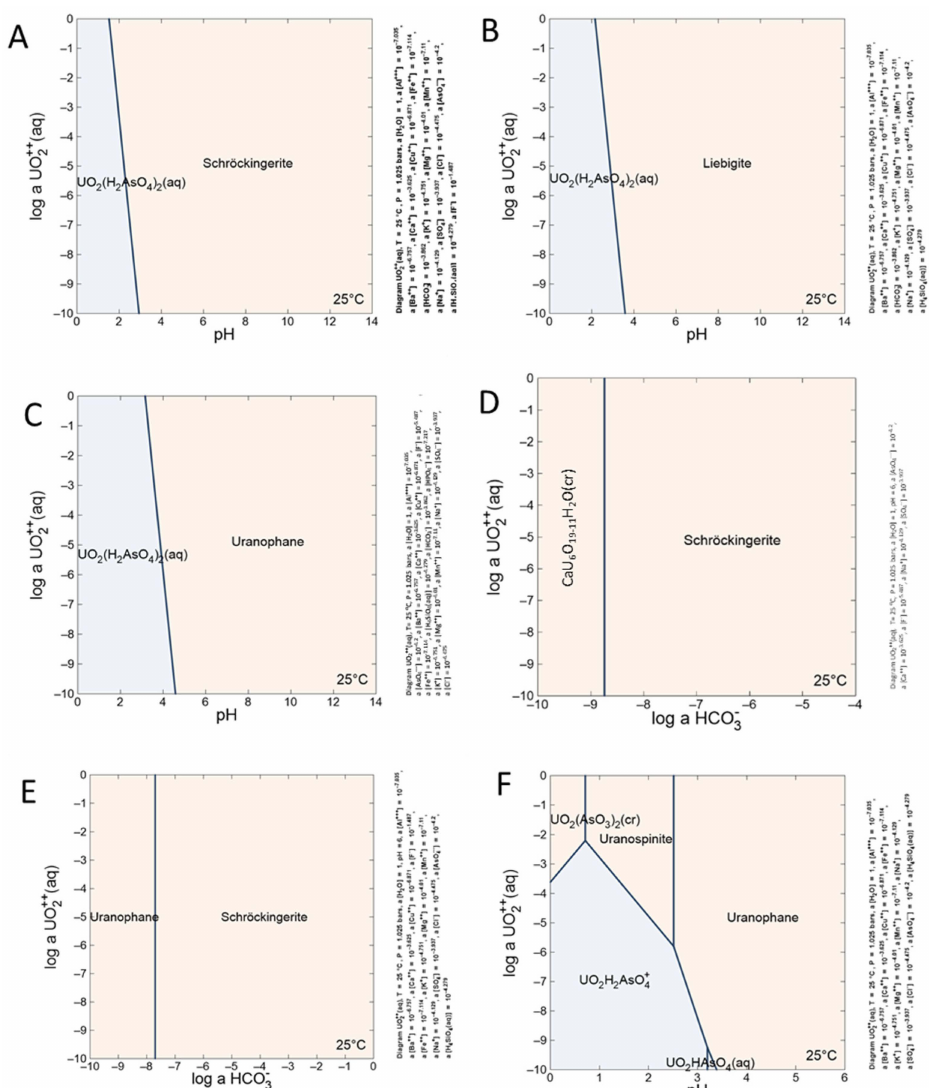
Figure 15. Stability fields of selected uranyl minerals from Podg ó rze mine. ( A , B ) Uranyl ion activity versus pH for schröckingerite and uranophane, respectively. ( C , D ) Stability fields of uranospinite– schröckingerite and uranophane–schröckingerite, respectively, depending on UO 2 2+ , HCO 3 − , and UO 2 (H 2 AsO 4 ) 2 (aq) activity. ( E , F ) Dependence on uranyl activity and pH of liebigite and uranospinite,